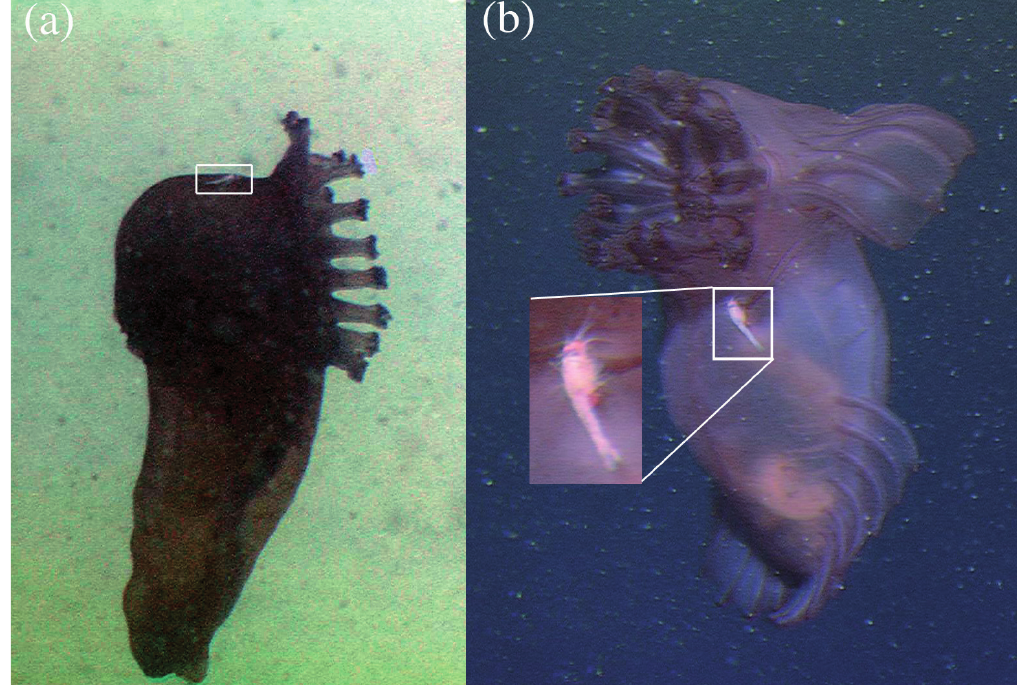
Fig . 4. – (a) in situ hDTV video framegrab of Enypniastes eximia observed on 20 May 2000. associated mysid located within a rectangle. (b) in situ hDTV video framegrab of Enypniastes eximia observed on 4 February 2004. inset is a portion of a separate zoomed-in video framegrab of the associated mysid.